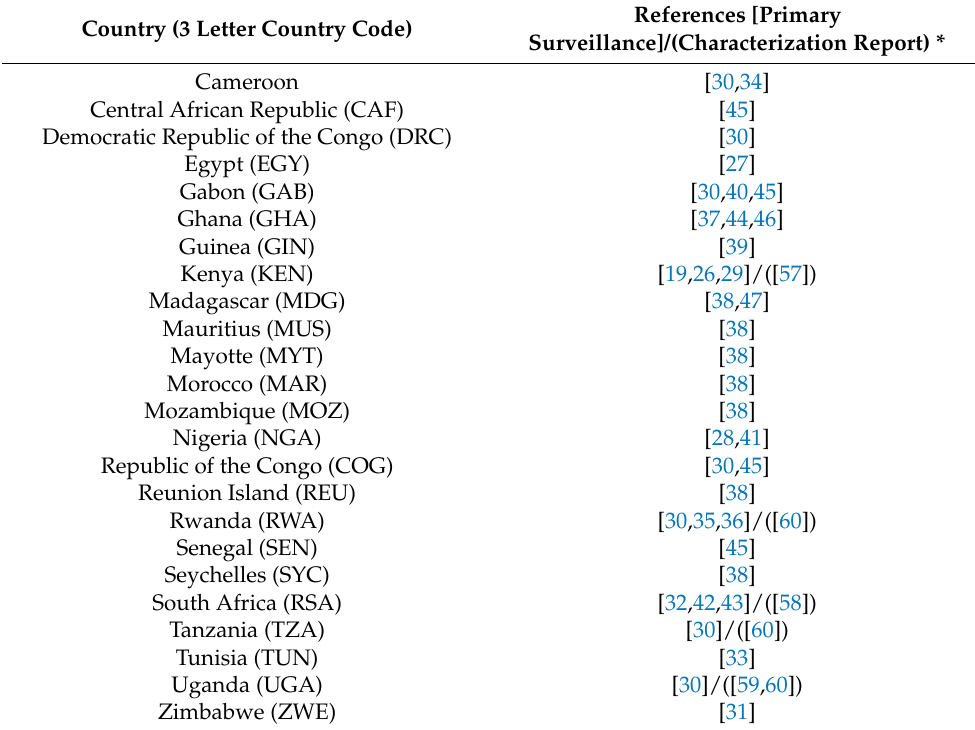
Table 2. Bat coronavirus surveillance performed in Africa, per country.